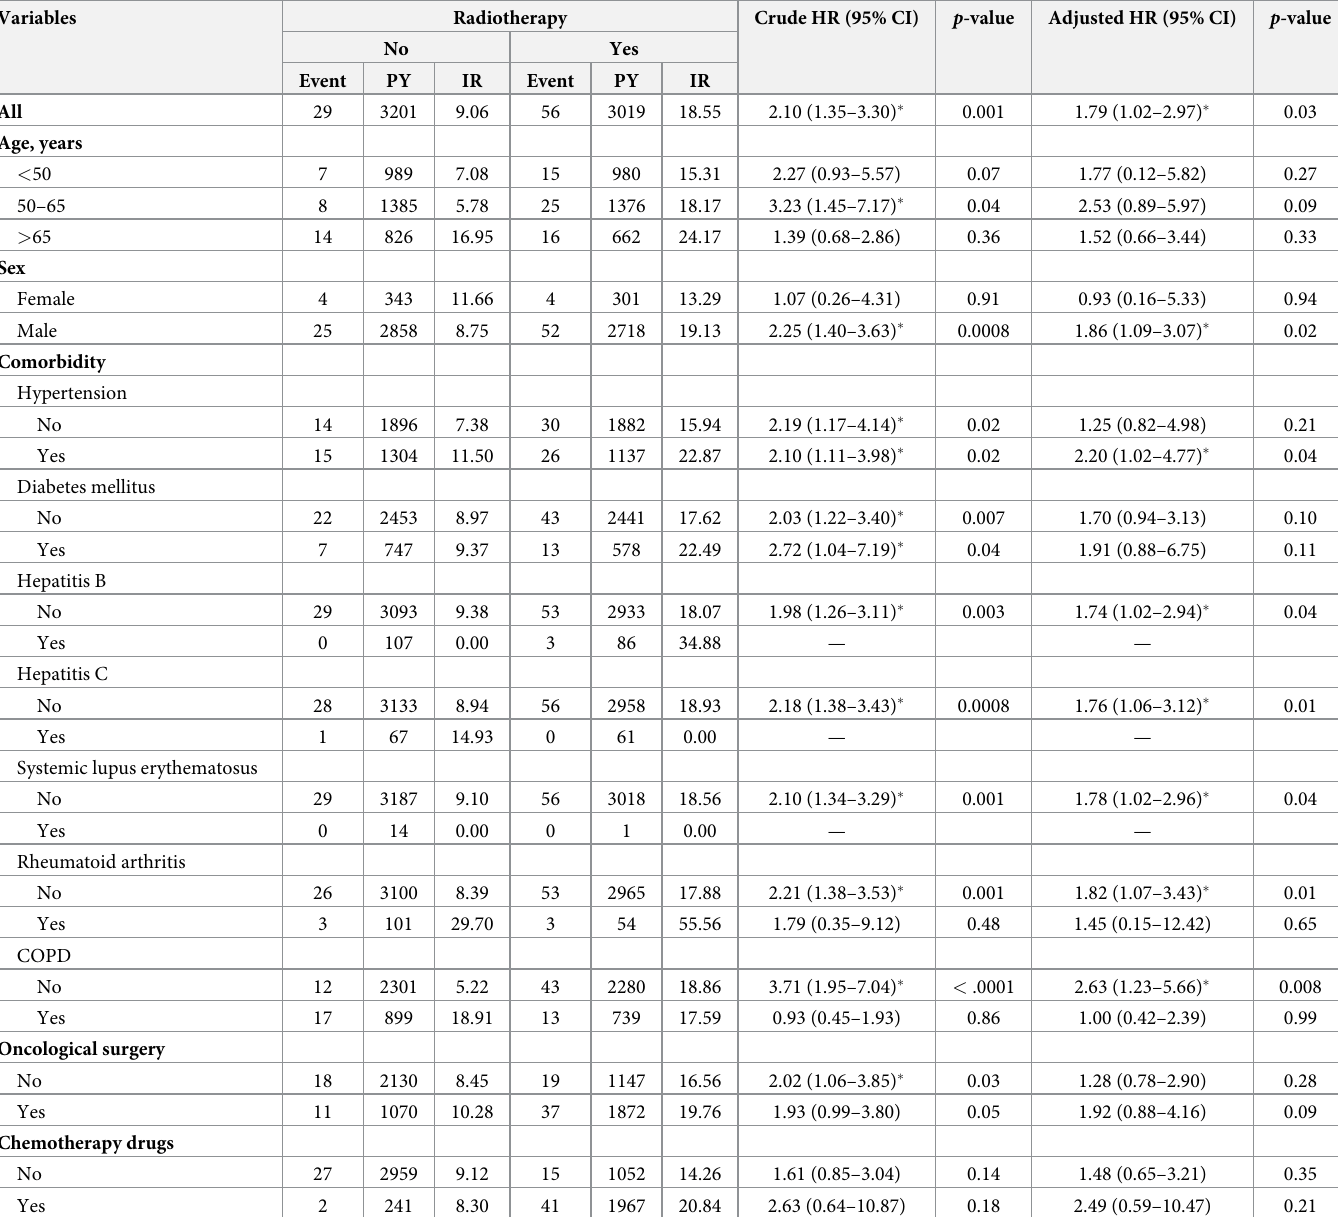
Table 3. Univariate and multivariate analyses of the effects of RT stratified by age, sex, comorbidities, oncological surgery, and chemotherapy drugs.